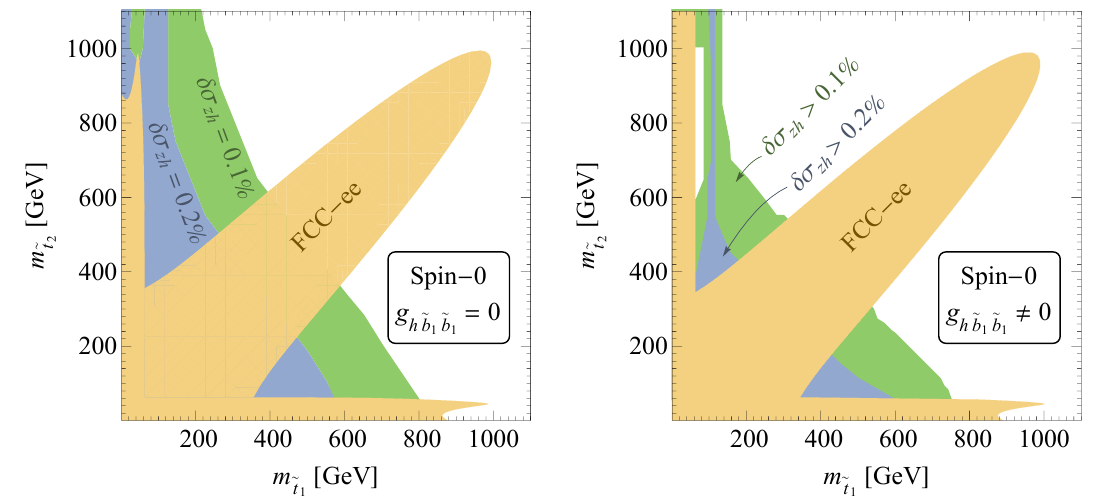
Figure 11 . Expected sensitivities at the 2 (cid:27) C.L. of FCC-ee for spin-0 models with additional constraints from (cid:14)(cid:27) Zh . In the left plot, we assume tan (cid:12) ’ 1 and h ~ b 1 ~ b 1 coupling vanishes (eq. (5.23)), while in the right plot, tan (cid:12) is large to maximize the D -term contributions in the stop and sbottom sector (eq.